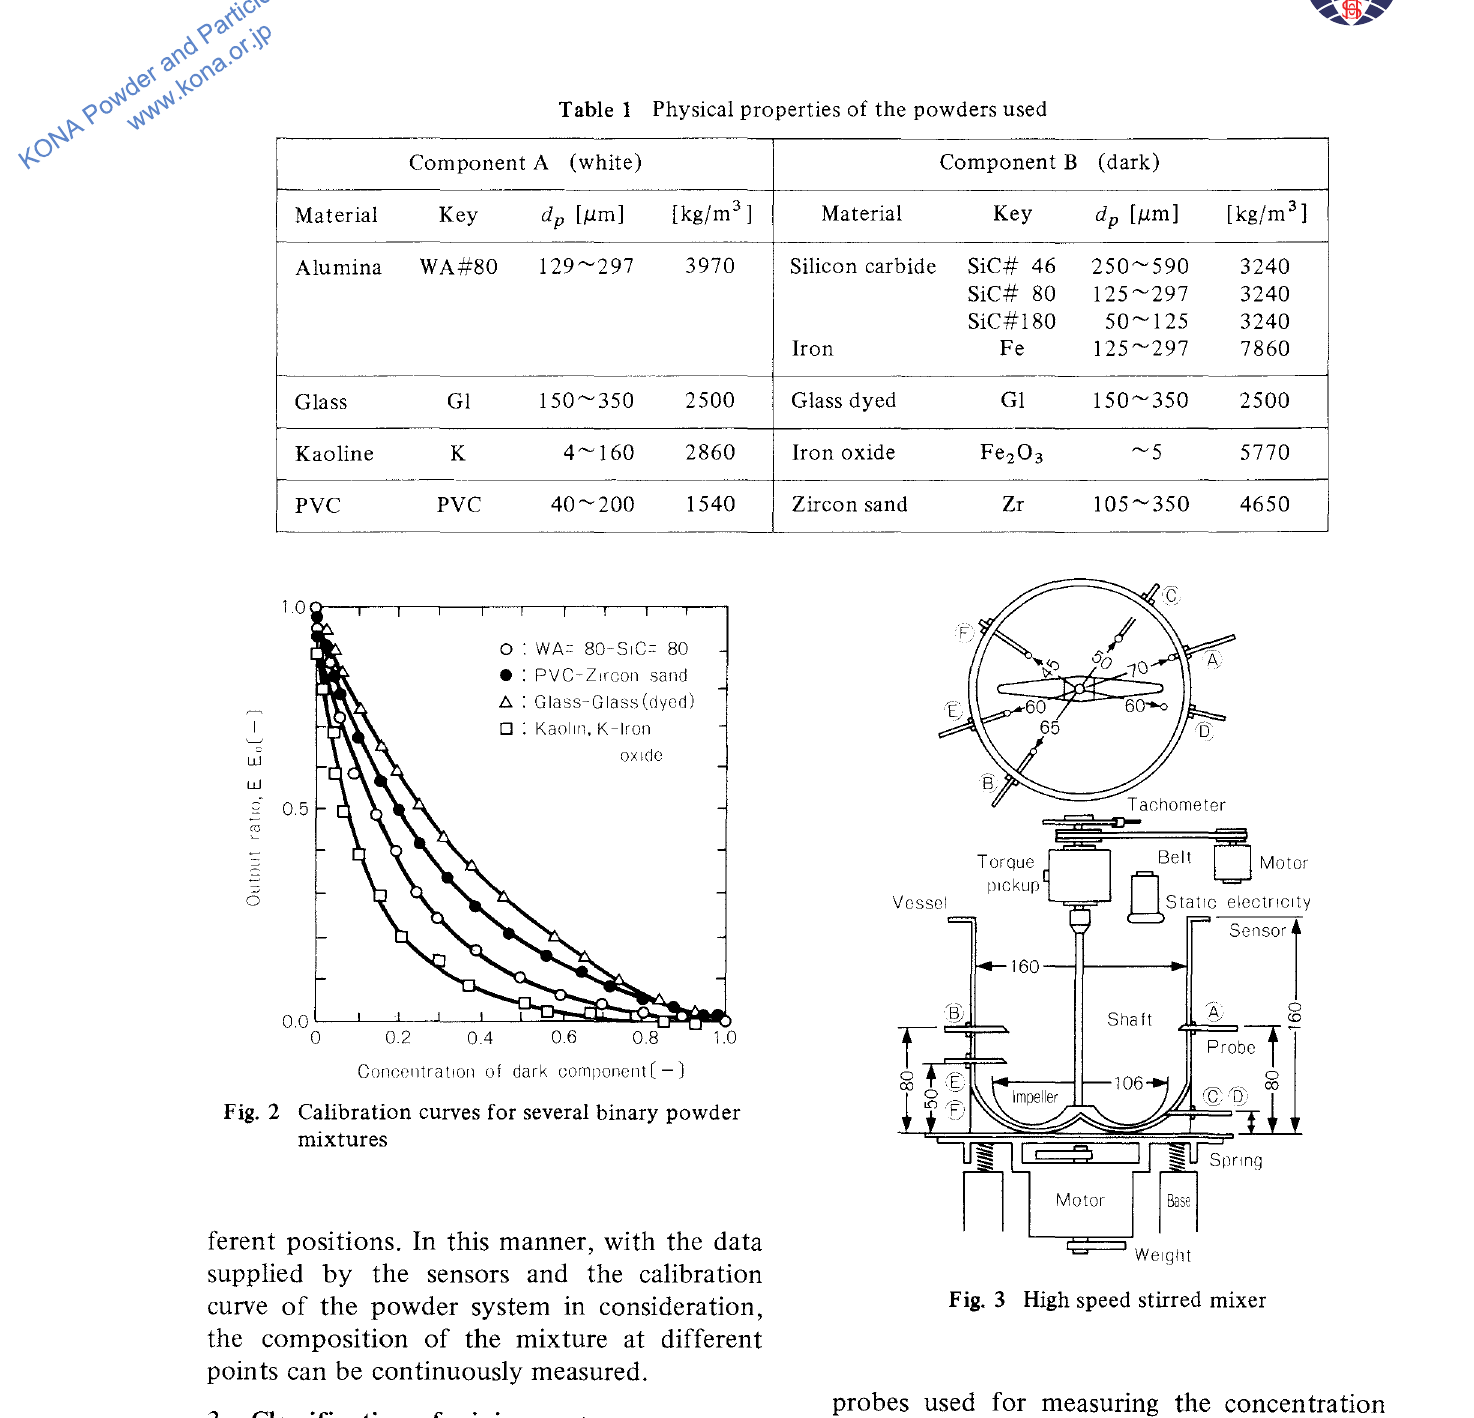
probes used for measuring the concentration were inserted horizontally at different depths into the vessel and also at different distances from the wall. In the experiments, first the A component (white) is placed within the vessel, which is then vibrated at the prescribed fre quency Nv (Hz), and the impeller is also set in motion at the desired speed NR (rpm). Once the A component has been agitated for a while under those fixed conditions, the B component (colored) is added at timet= 0 onto the bed in the form of a pulse